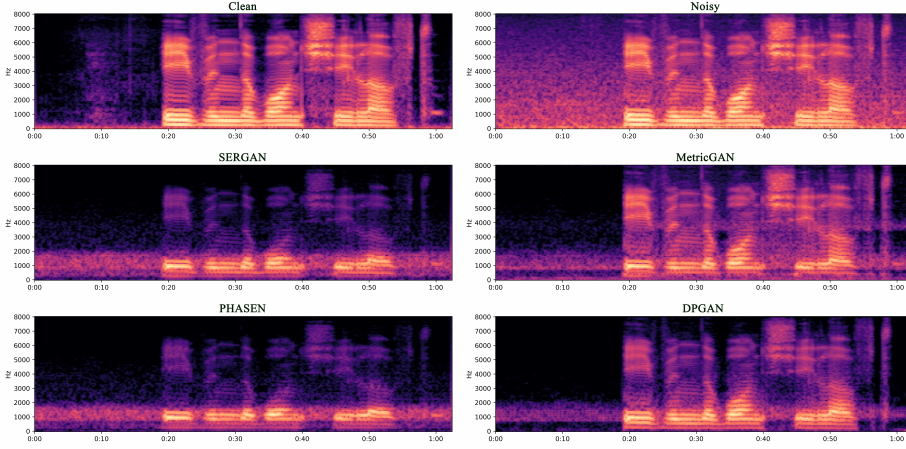
Figure 9. A comparative spectrogram of the enhancement effect of full-band noise at lower signal- to-noise ratios is shown. This contains most of the low frequency noise, which is shown as lighter coloured blurred noise in the plot.